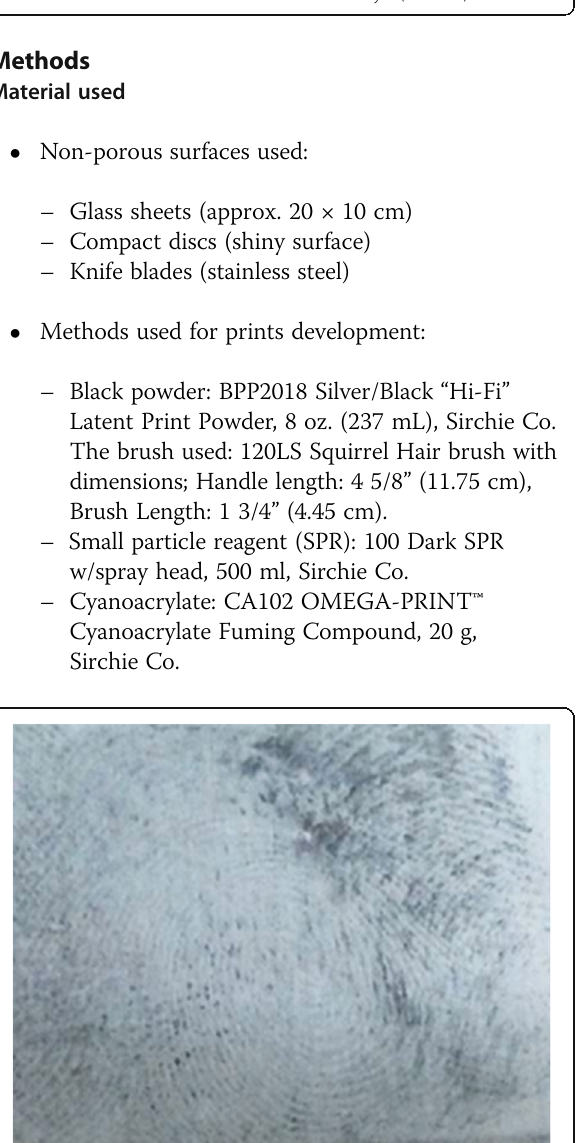
Fig. 5 Developed fingerprint using cyanoacrylate on glass surface after submersion in fresh water for 1 day (Score 5)